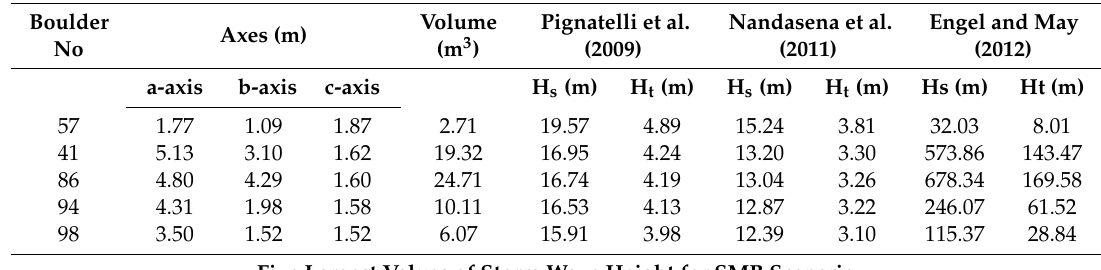
Table 2. Selected boulder measurements and storm wave height calculations based on di ff erent hydrodynamic equations [22–24,48,49]. All boulder measurements and calculations are provided in Table